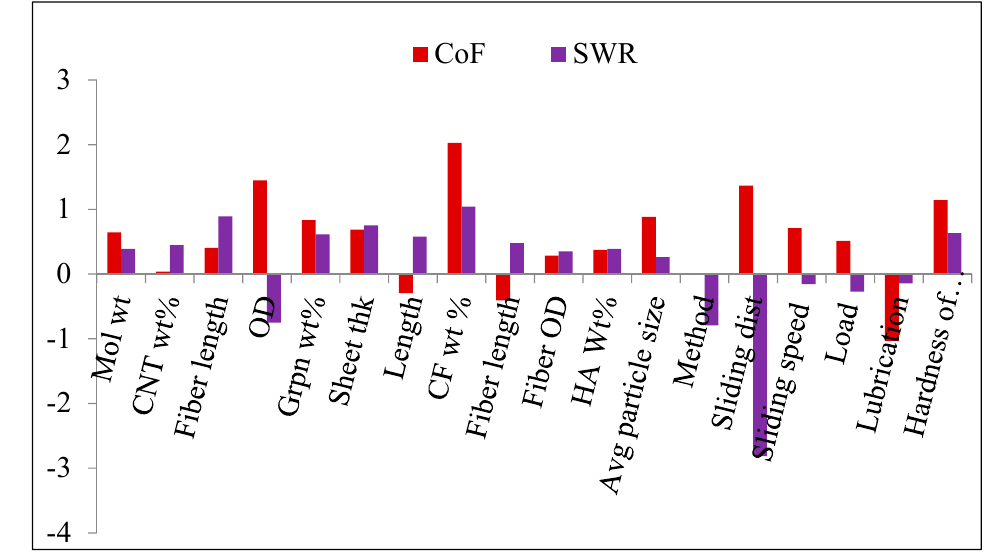
Figure 5. Sensitivity analysis for CoF and SWR.